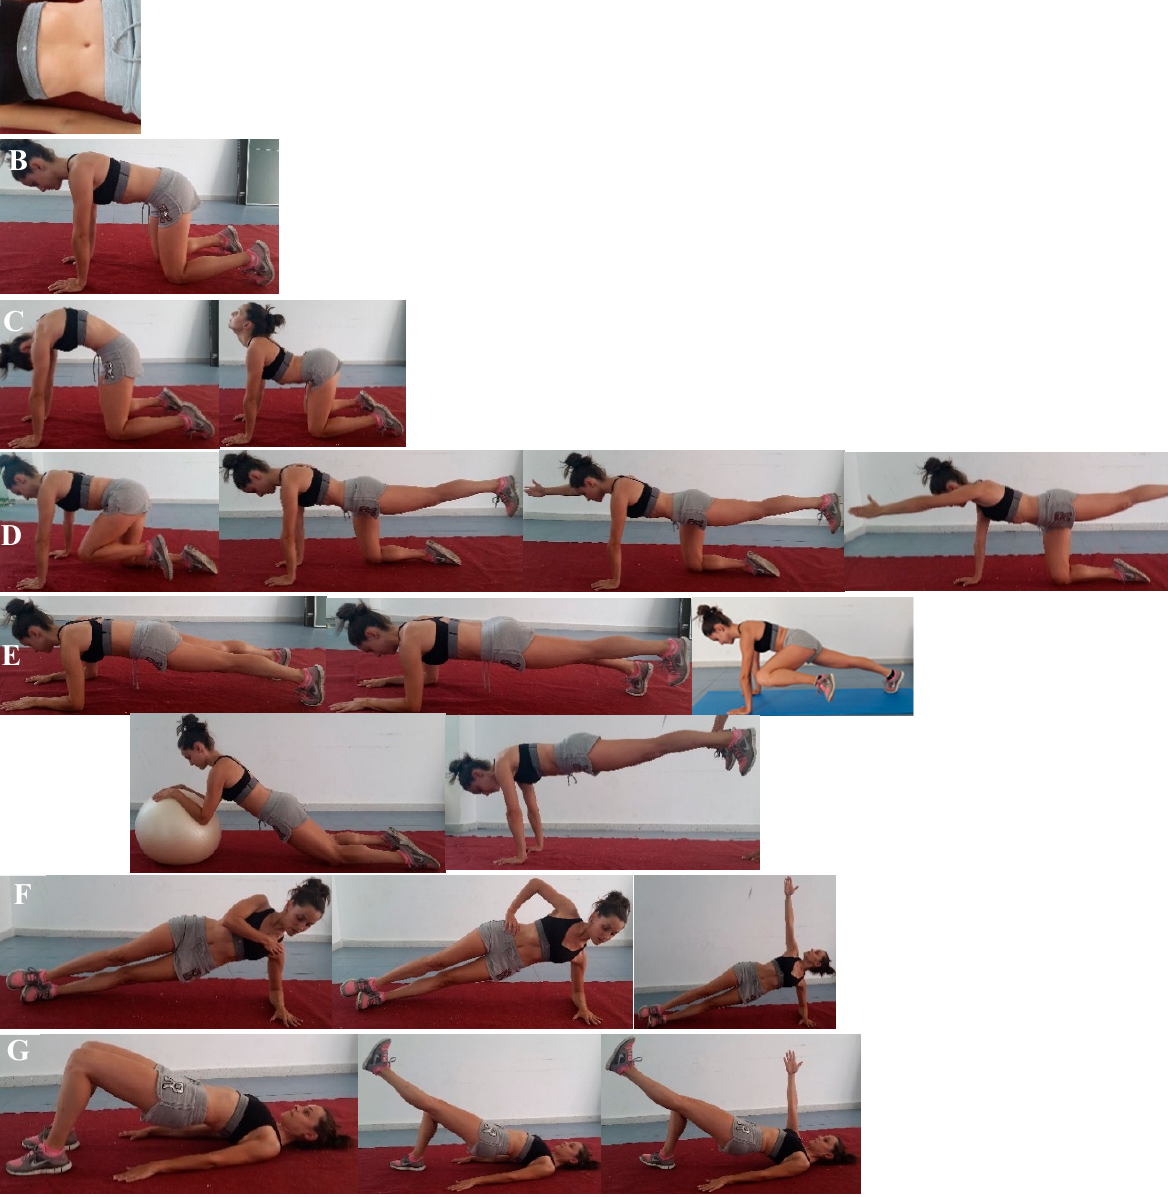
Figure 2. Core muscular training exercise. ( A ) Hollowing; ( B ) Bracing; ( C ) Dissociation; ( D ) Cat-Camel; ( D ) Quadrupedal; ( E ) Front Bridge; ( F ) Side Bridge; ( G ) Supine Bridge. Table 2. The Core program.